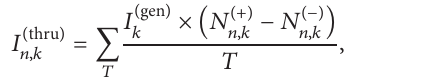
Figure 3: Schematic diagram of calculation of trajectories of 𝐼